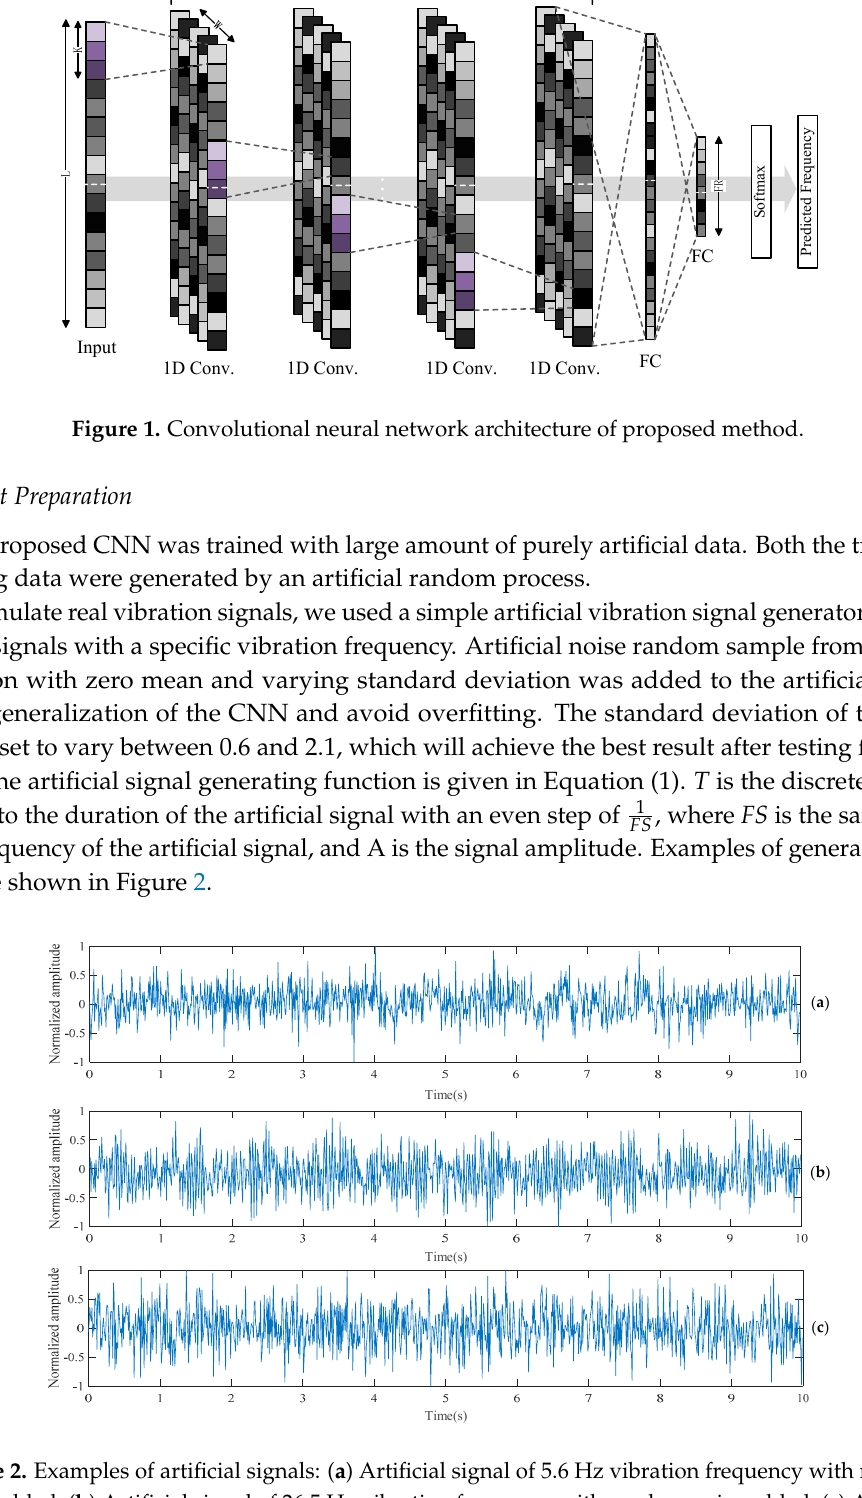
Figure 2. Examples of artificial signals: ( a ) Artificial signal of 5.6 Hz vibration frequency with random noise added; ( b ) Artificial signal of 26.5 Hz vibration frequency with random noise added; ( c ) Artificial signal of 46.8 Hz vibration frequency with random noise added.